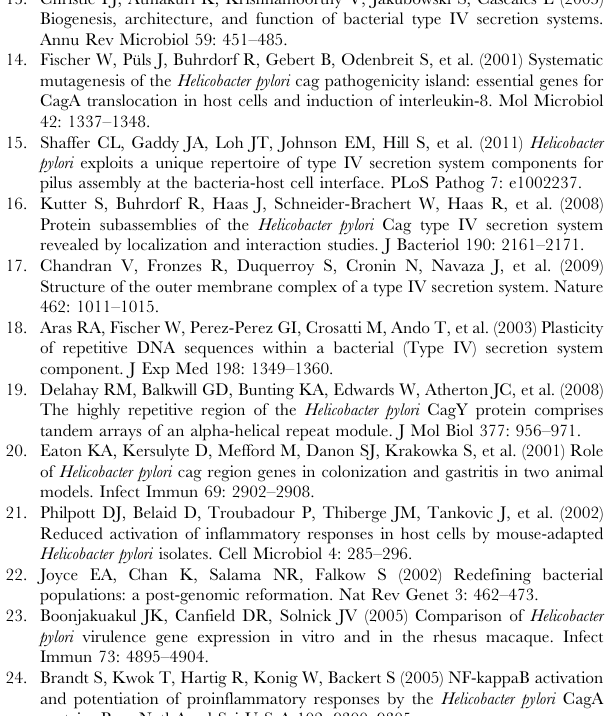
Figure S6 Complementation of mOut2 with WT cagY